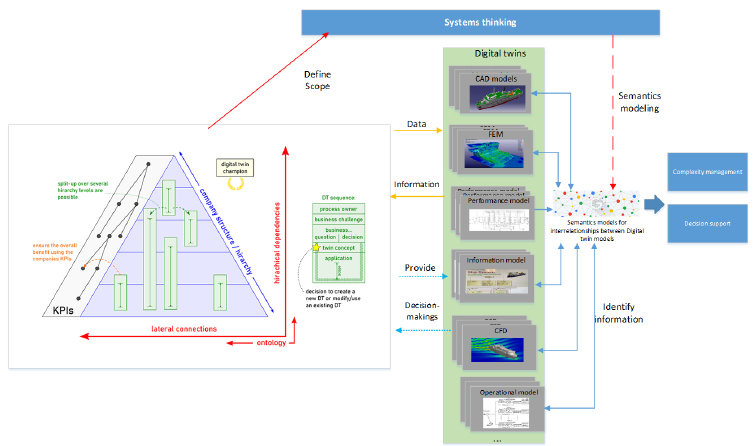
Figure 5. Semantic modeling for digital